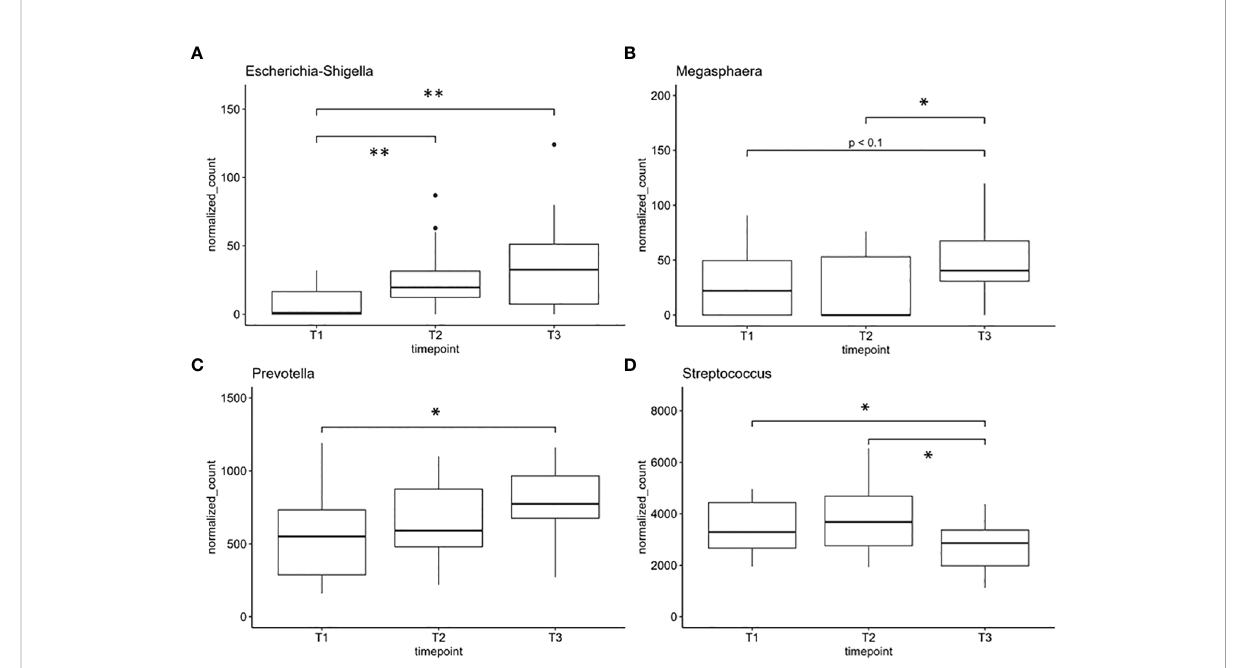
FIGURE 5 Genera with signi fi cant differences in normalized counts between sample groups: (A) Escherichia/Shigella, (B) Megasphaera, (C) Prevotella, and (D) Streptococcus, one of the most abundant genera. *indicates pvalue < 0.05. **indicates pvalue < 0.01. T1: before/at start of chemotherapy, T2: 12 weeks after the onset of chemotherapy, T3: 52 weeks after the onset of